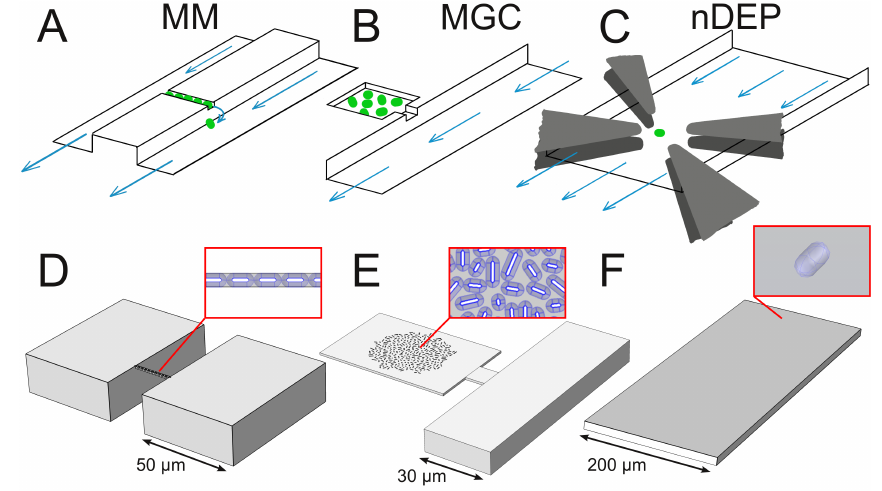
Figure 1. Investigated microfluidic trapping and cultivation devices: ( A ) mother machine (MM) with growth channel connected to two supply channels, ( B ) monolayer growth chamber (MGC) connected to one supply channel, and ( C ) negative dielectrophoresis (nDEP) within supply channel. Cells are indicated by green dots and fluid flow by blue arrows. ( D – F ) illustrate respective CFD geometries. ( F ) features an extended channel after the cell trap to reduce the impact of computational artefacts at the exit boundary. Red insets show microcolonies in geometries ( D , E ), geometry ( F ) contains a single